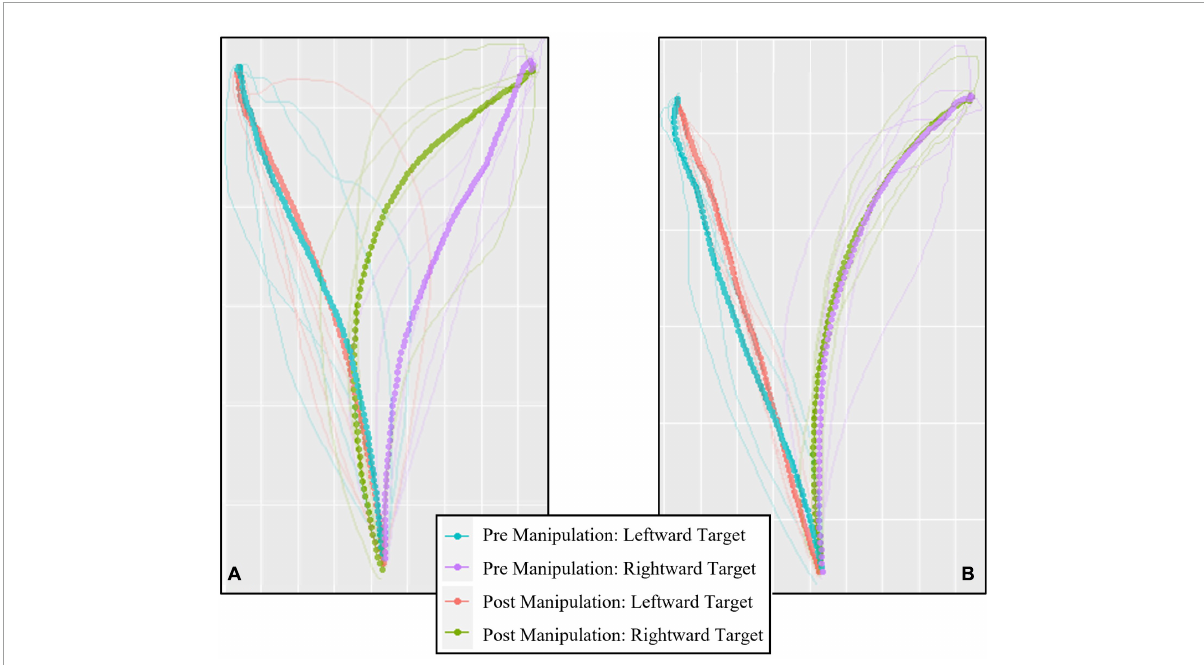
FIGURE3 An example of the trajectories generated by a single participant executing cursor movements toward the Perceived Large (A) and Perceived Small (B) target. Solid lines represent data from each trial, dotted lines represent the average trajectory for each condition. Plot generated using the mt_plot_aggregate function from the mousetrap package in R (Kieslich and Henninger, 2017).